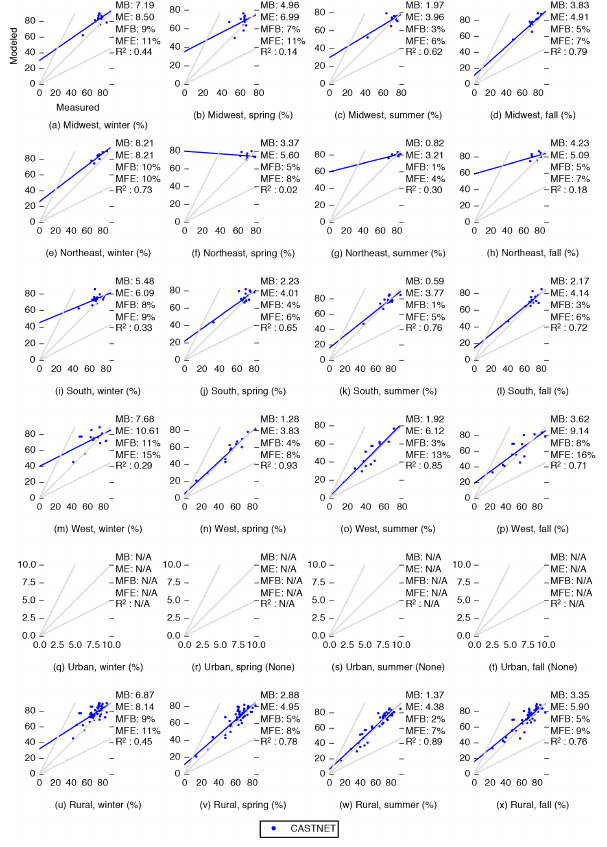
Figure A5. Comparison of modeled and measured precipitation, disaggregated by region and